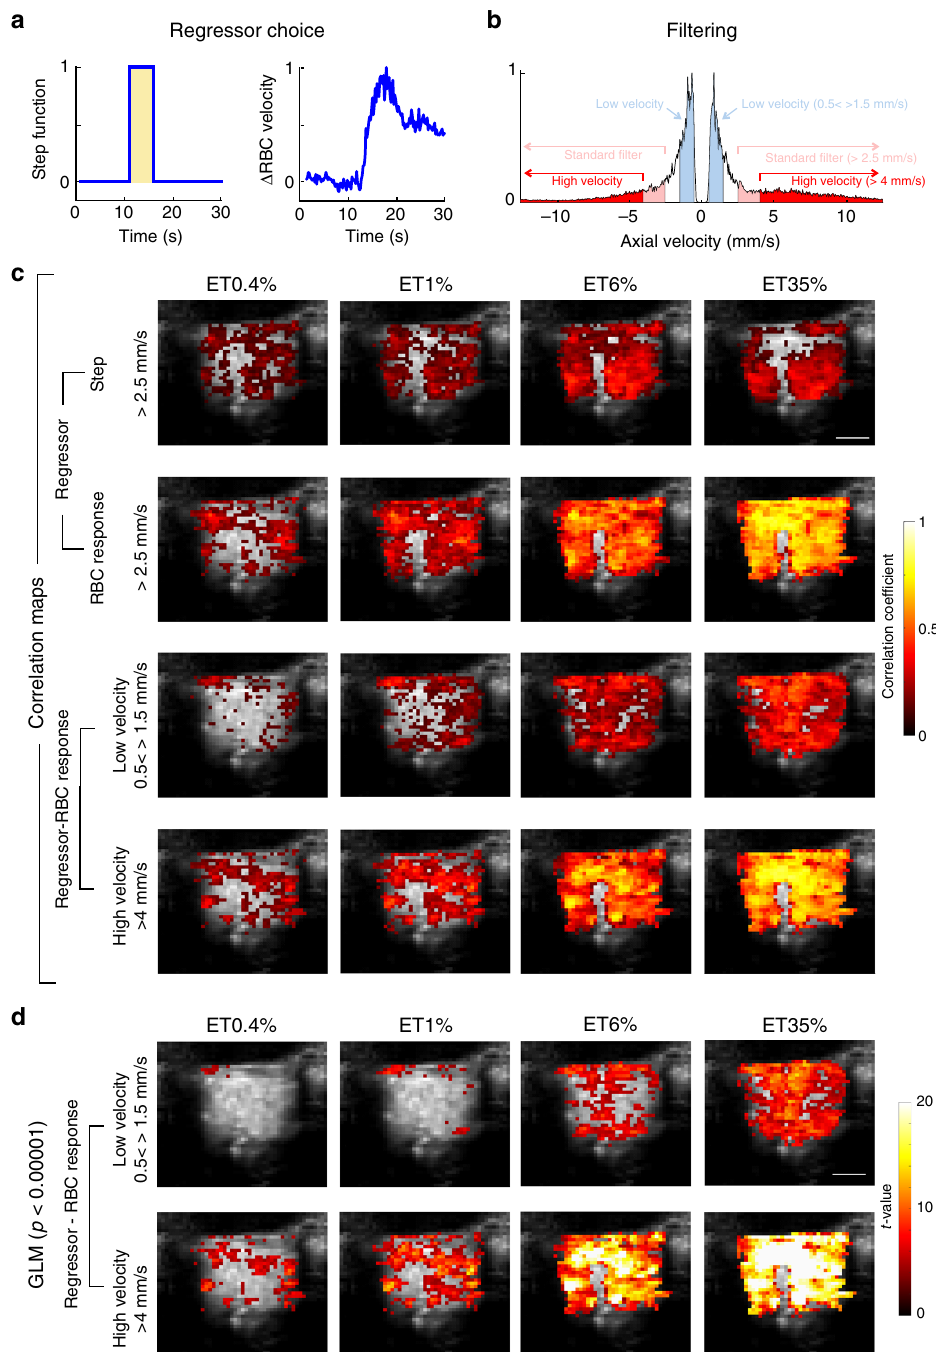
Fig. 5 Mapping vascular activation with fUS. a Shows regressor used for building fUS activation maps: Left: step function; Right: capillary RBC velocity response (here at 35% ET). b Spectrum of Doppler frequencies converted to axial velocity (mm/s). Different fi lters were used for the analysis. Either a standard high-pass (HP) fi lter (reporting the CBV fraction fl owing with an axial velocity > 2.5 mm), a higher HP fi lter reporting an axial velocity > 4 mm/s or a band-pass fi lter reporting an axial velocity between 0.5 and 1.5 mm/s). c Top two lines: comparison of the correlation maps obtained with the two regressors, using a standard HP fi lter. Using the RBC response as a regressor signi fi cantly improves the quality of the map, in particular in the dorsal OB. Bottom two lines: correlation maps for low axial velocities, i.e. comprising capillary responses differ from the large vessel maps (high axial velocities). d Activation maps of low and high axial velocity vessels using the general linear model with the RBC response as a regressor and a statistical threshold